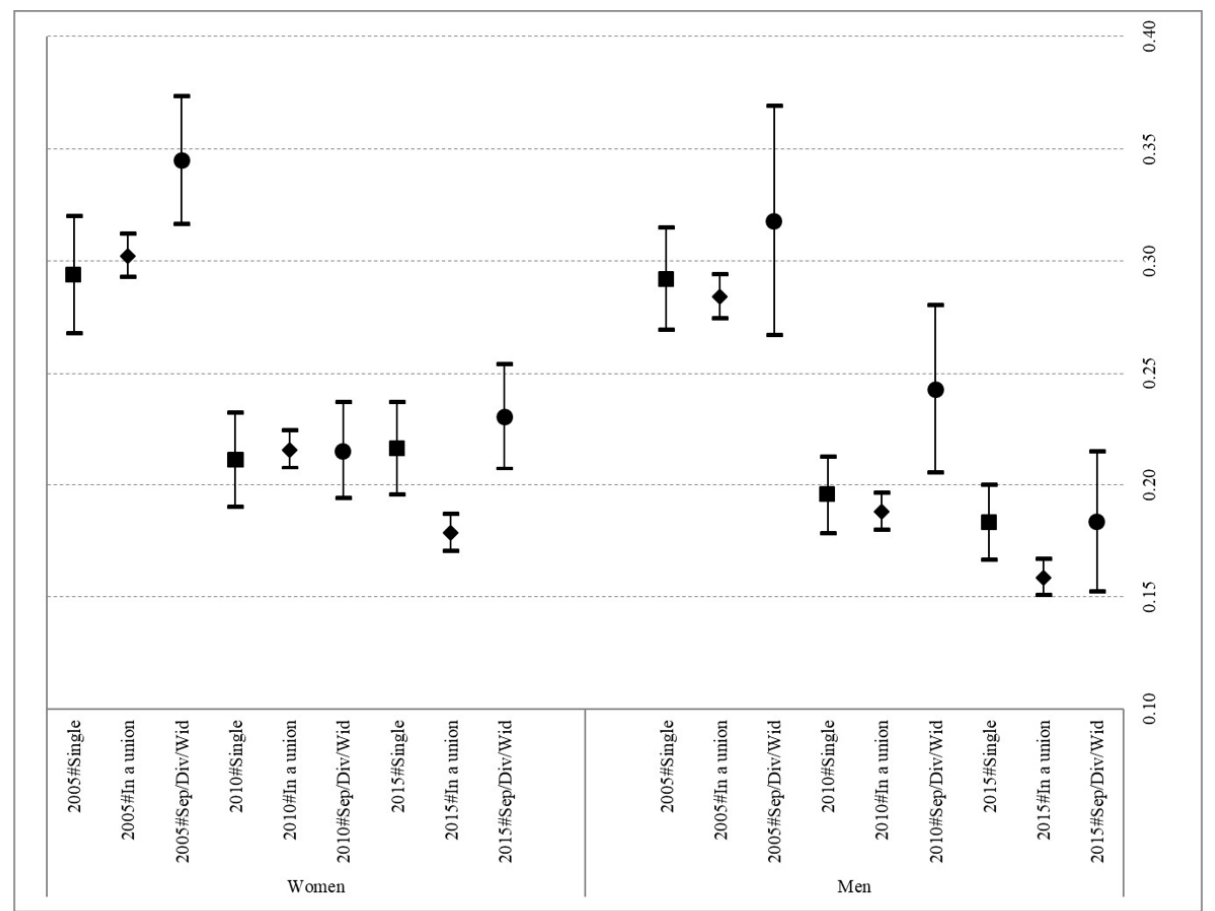
Figure 1. Predicted probabilities of poor health according to partnership status and year in Spanish women and men aged 30–59. 2005, 2010 and 2015. Source: Spanish sample EU-SILC 2005, 2010 and 2015. Note: Both models control for education, employment status, capacity to make ends meet, living with children < 16 and age.